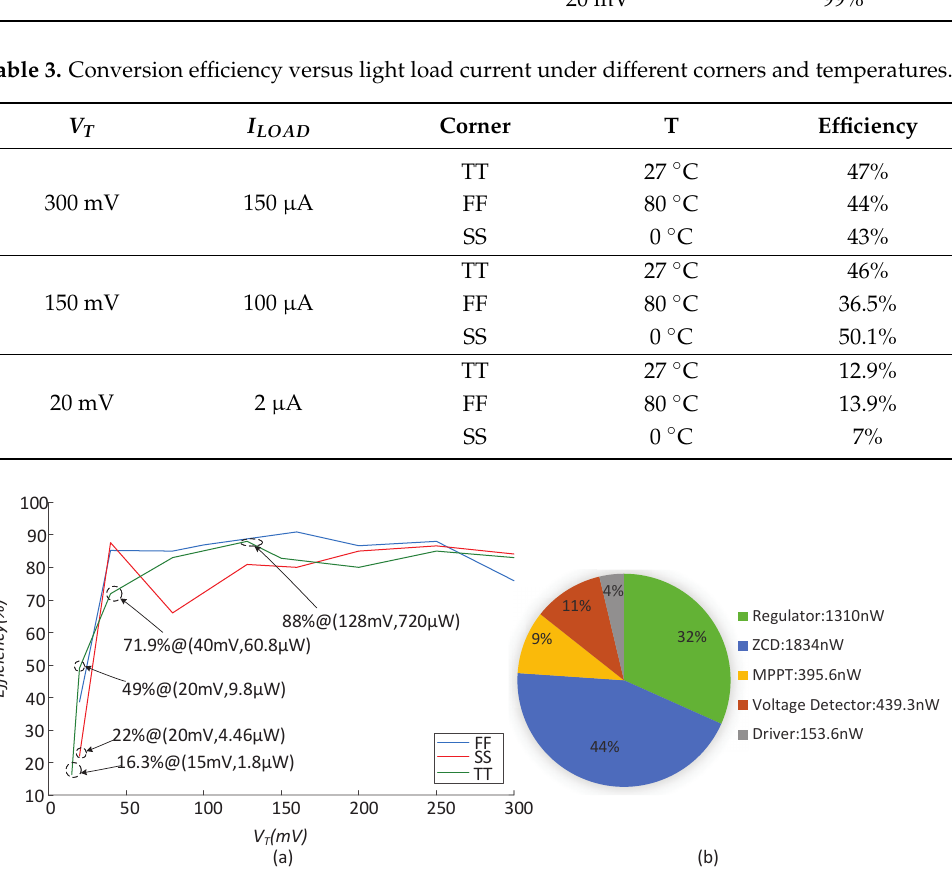
Figure 16. ( a ) The conversion efficiency and key output power in different corners in 27 ◦ C; ( b ) the power consumption of each